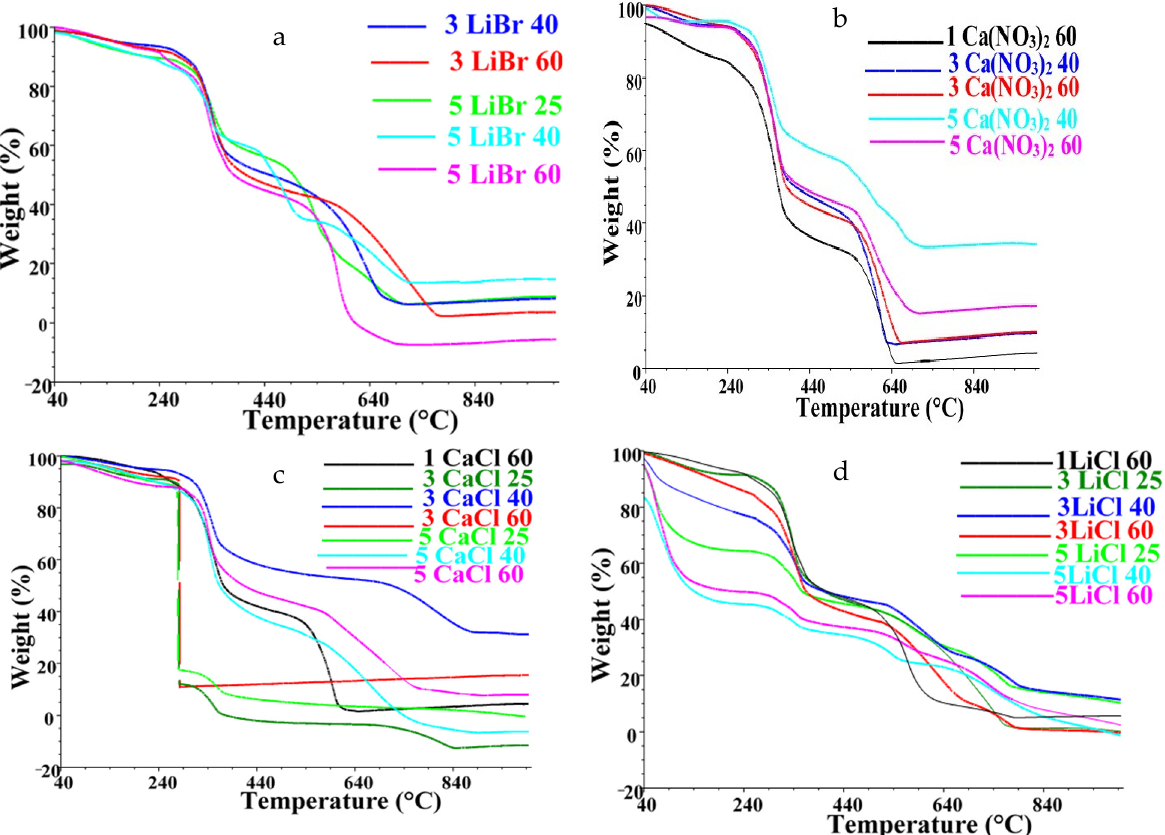
Figure 12. TG curves of silk fibroin films for ( a ) LiBr, ( b ) Ca(NO 3 ) 2 , ( c ) CaCl 2 , and ( d ) LiCl.